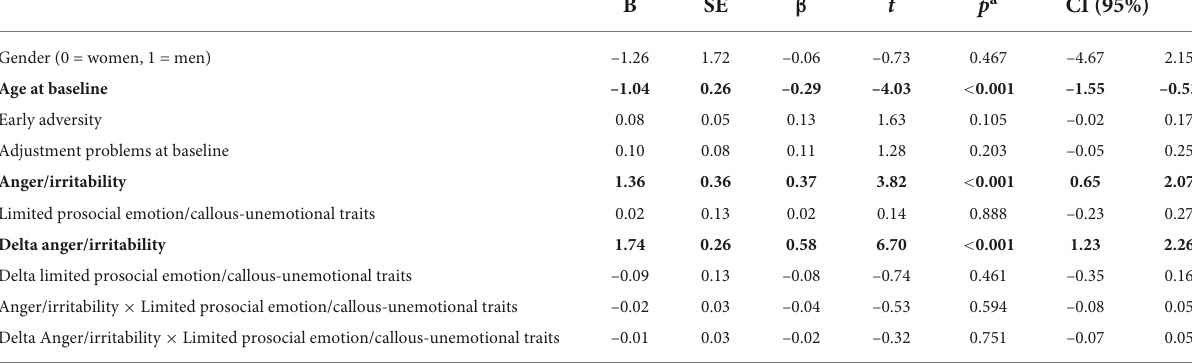
TABLE 6 Prediction of adjustment problems at